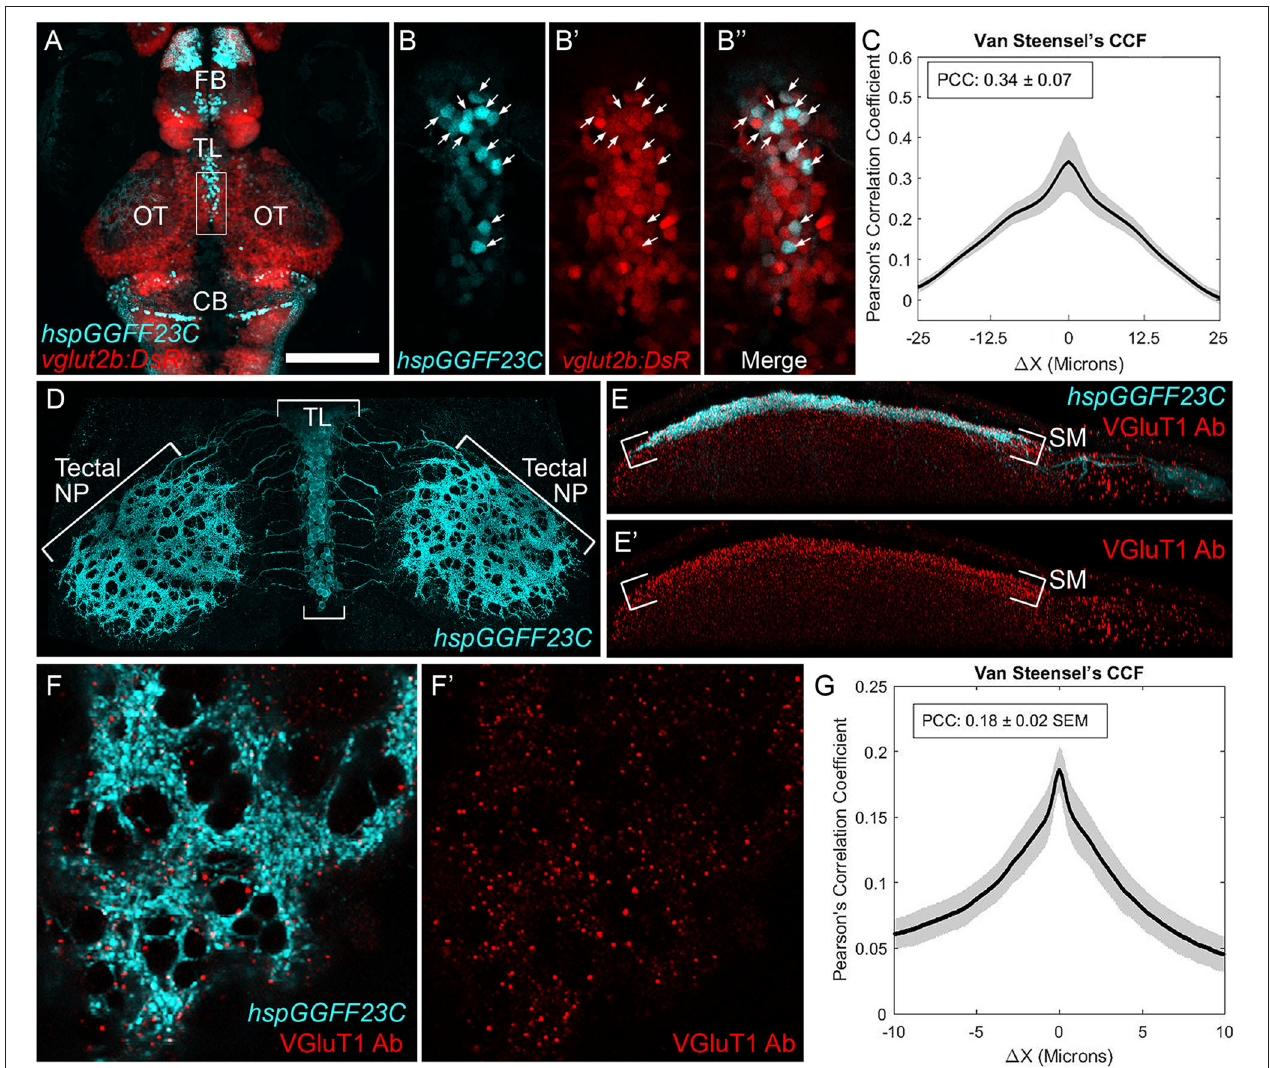
FIGURE 3 | Axonal projection from TL to tectum is glutamatergic. (A) Dorsal view confocal image of EGFP and DsRed fluorescence in the brain of a Tg( hspGGFF23C,uas:egfp,vglut2b:rfp) larva. (B) Magnified views of region indicated by box in (A) showing the EGFP (B) , DsRed (B ′ ) , and merged (B ′′ ) fluorescence channels. Arrows indicate neurons with EGFP and DsRed colocalization. (C) Van Steensel’s cross-correlation functions of EGFP and DsRed overlays. Local maxima of Pearson’s Coefficient (PC) near 1 X = 0 indicates colocalization. N = 10 larvae. (D) Dorsal view confocal image of the tectum in a 7 dpf Tg( hspGGFF23C,uas:egfp) larva fixed and immunofluorescently stained with anti-EGFP antibody. Note dense plexus of EGFP-positive axons in SM. (E) Side-view of a single tectal lobe from tectum in (D) , including immunofluorescent staining with anti-VGluT1 antibody in red channel. Note superficial EGFP labeling in SM layer and punctate VGluT1 immunofluorescence. Note increased density of puncta in SM layer. (F) High-resolution dorsal view of a SM subregion within tectum in (D) . Note overlap between VGluT1 puncta and EGFP-positive plexus and lack of VGluT1 labeling in EGFP-negative regions. (G) Van Steensel’s cross-correlation functions of EGFP and DsRed overlays for image in (F ′ ) . Local maxima of Pearson’s Coefficient (PC) near 1 X = 0 indicates colocalization. N = 4 larvae. Scale bar: 150 µ m in (A) , 30 µ m in (B,E) , 75 µ m in (D) , and 15 µ m in (F)